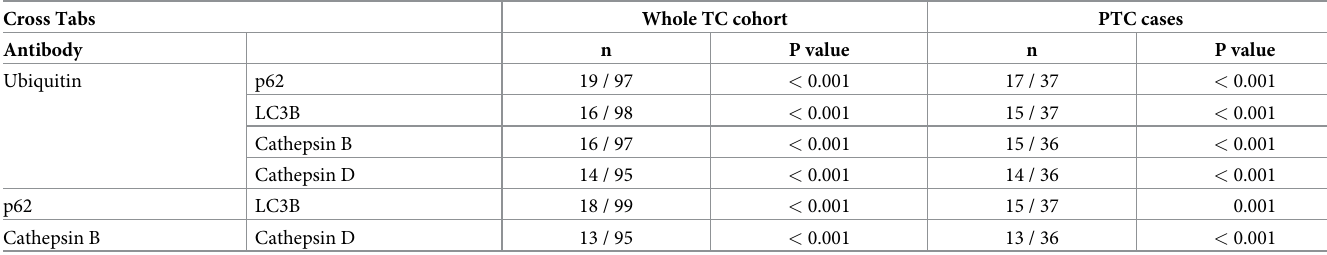
Table 4. Associations between p62, ubiquitin, LC3B, cathepsin B and cathepsin D immunoreactivity in intranuclear